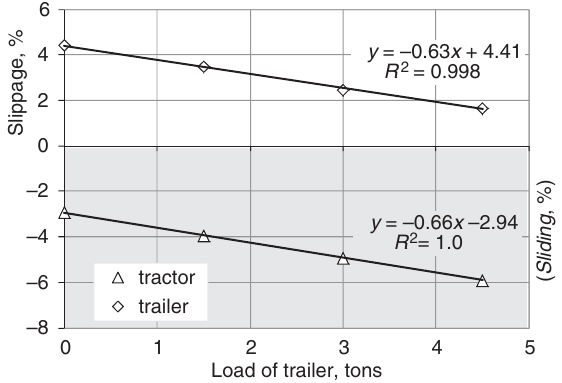
y = –0.66 x –2.94 R 2 = 1.0